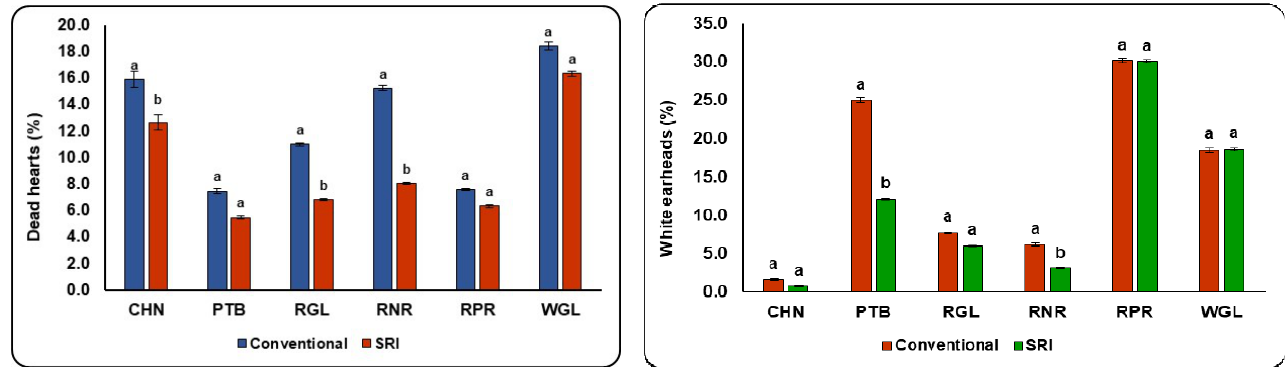
Figure 2. Stem borer incidence in SRI and conventional methods at various locations. CHN = Chinsurah, PTB = Pattambi, RGL = Ragolu, RNR = Rajendranagar, RPR = Raipur, WGL = Warangal. Means with the same letter are not significantly different by Tukey’s HSD ( p = 0.05) at each location.